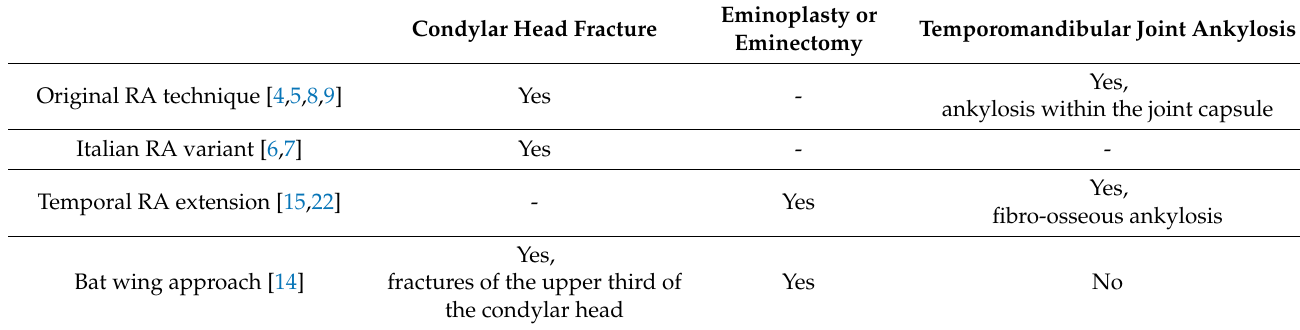
Table 7. Indications (Yes) and contraindications (No) specified in the content of the included studies. Boxes without data (-) indicate no mention in the articles included in this systematic